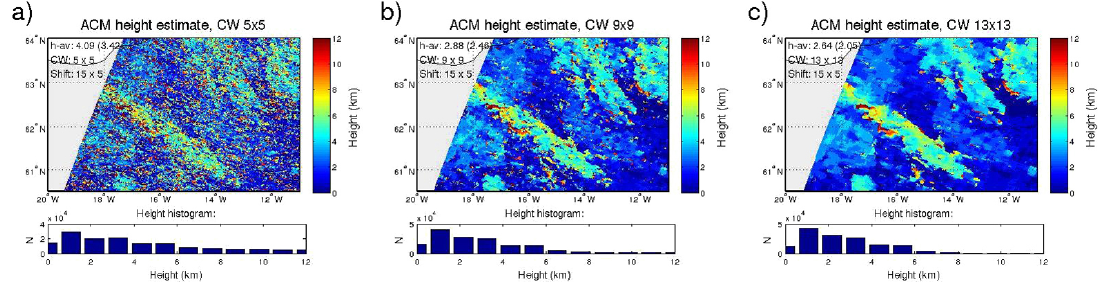
Figure 4. AATSR height estimate with three different CW sizes: 5 × 5, 9 × 9, and 13 × 13 . The average height for the full scene varies in the range of 2.6–4.1km for all CWS but settles at ∼ 2 . 6km when CWS is increased. Also, the standard deviation of height decreases with increasing CWS. The height histograms below the height maps show how the fraction of high-altitude pixels decreases with increasing